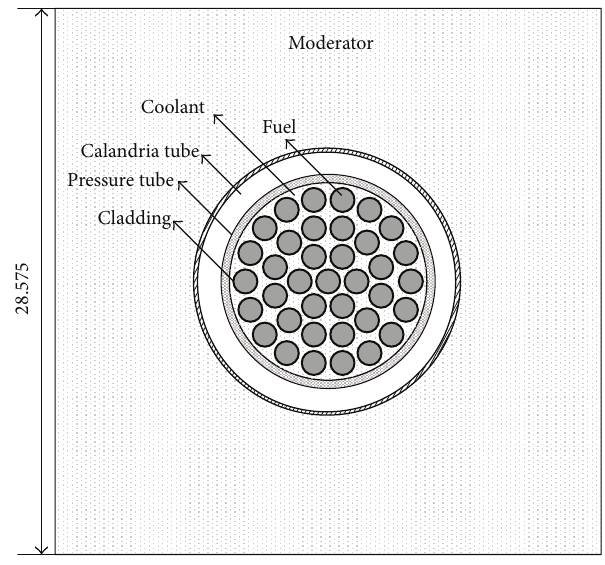
Figure 5: Standard lattice cell model.